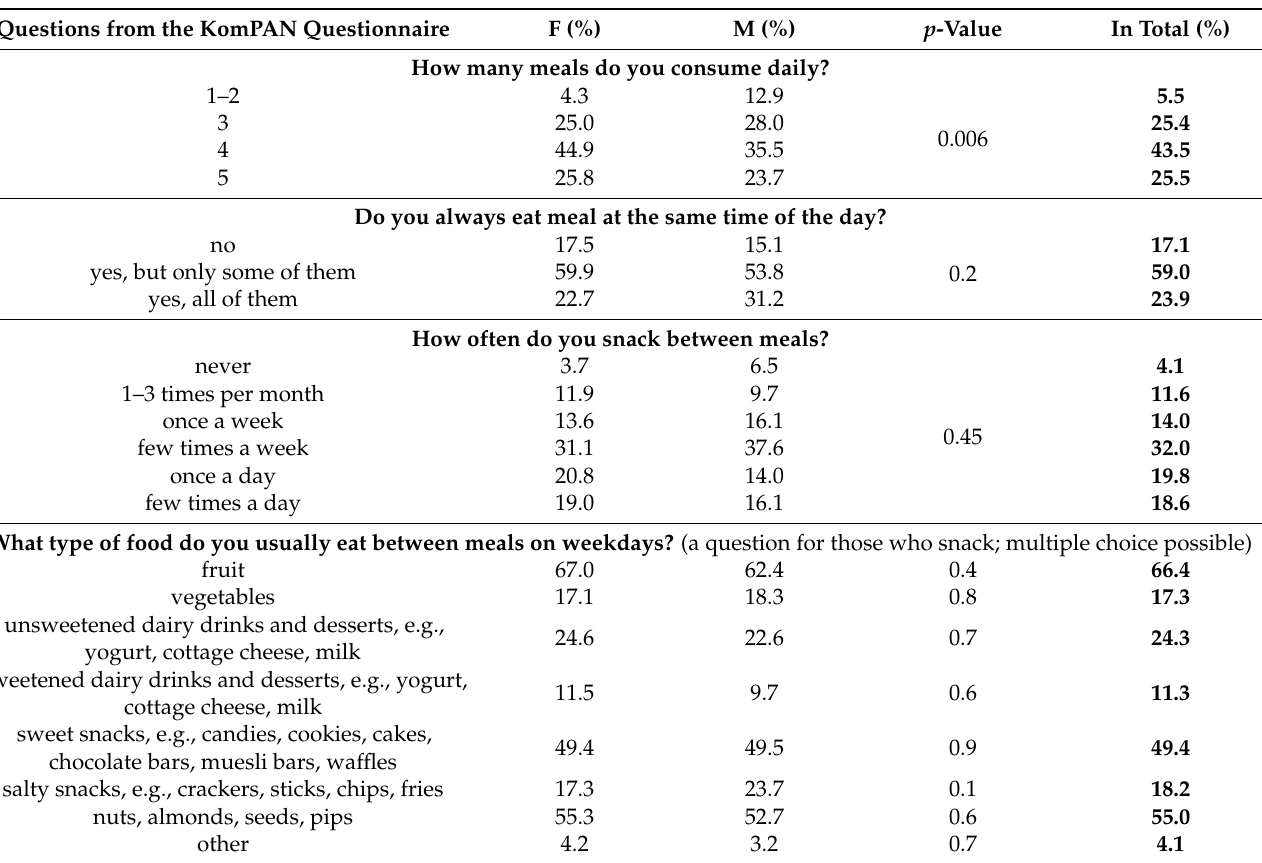
Table 1. Dietary patterns among Polish pharmacists ( n = 667).